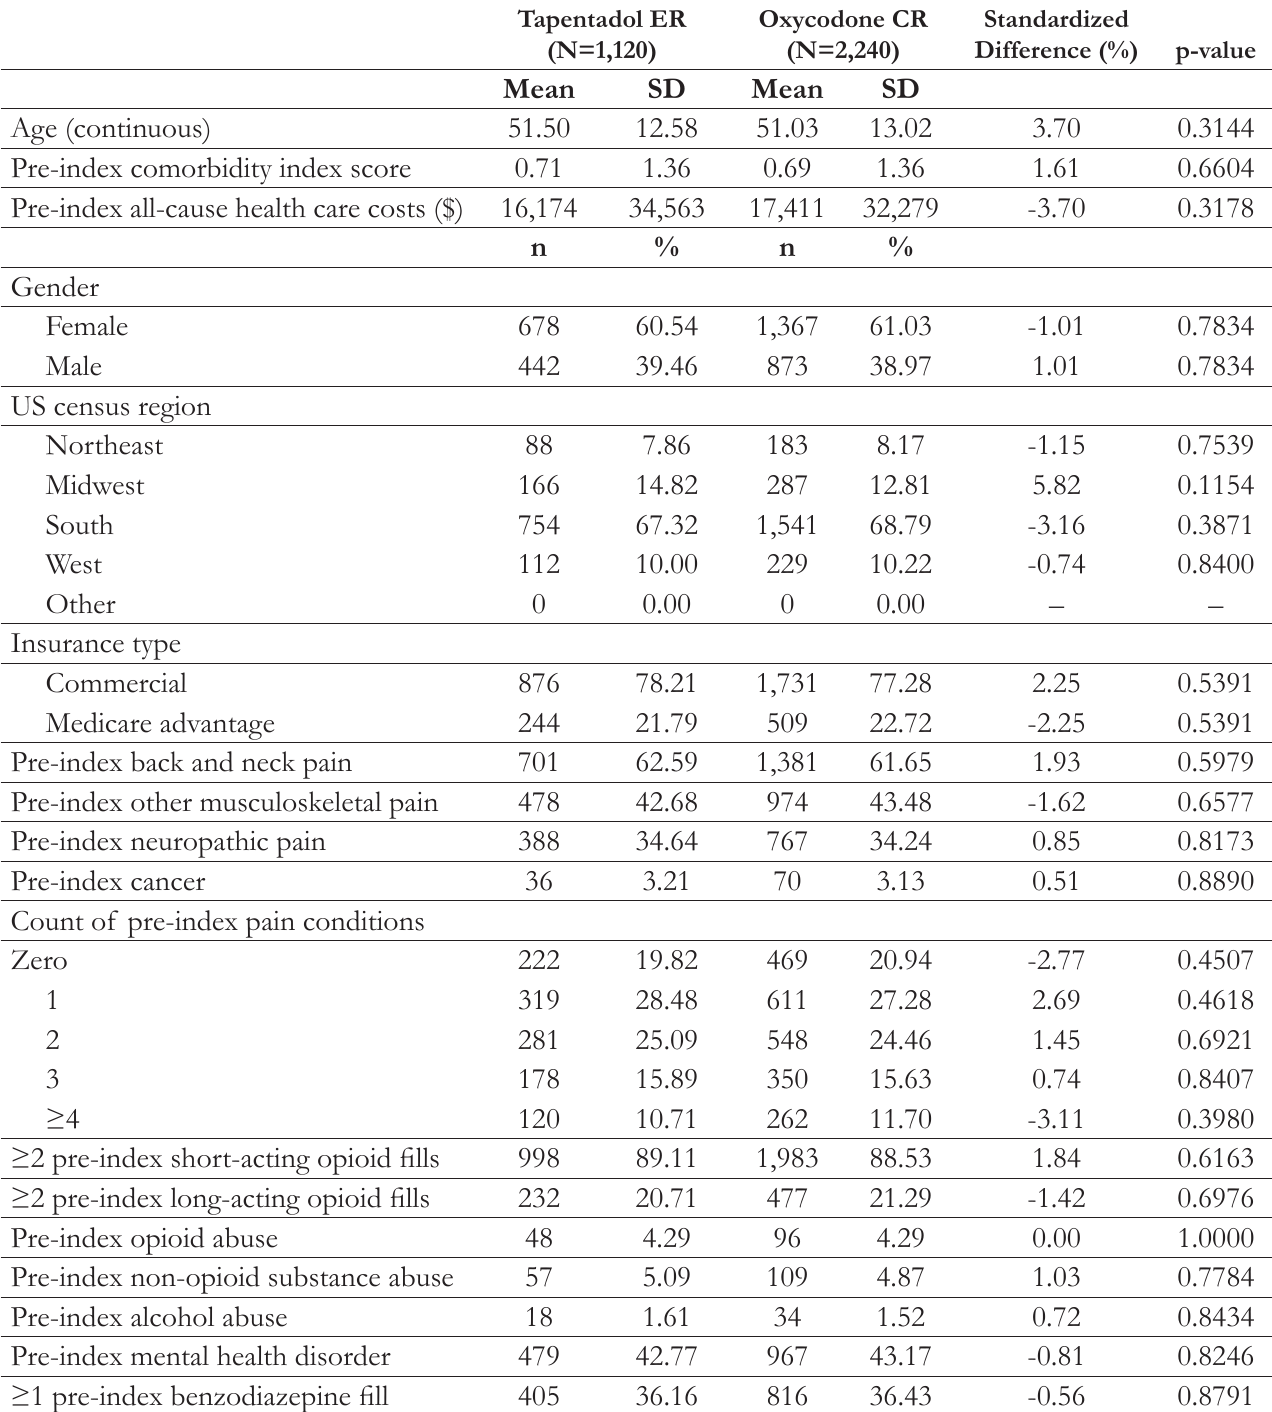
Table 2. Pre-Index Characteristics